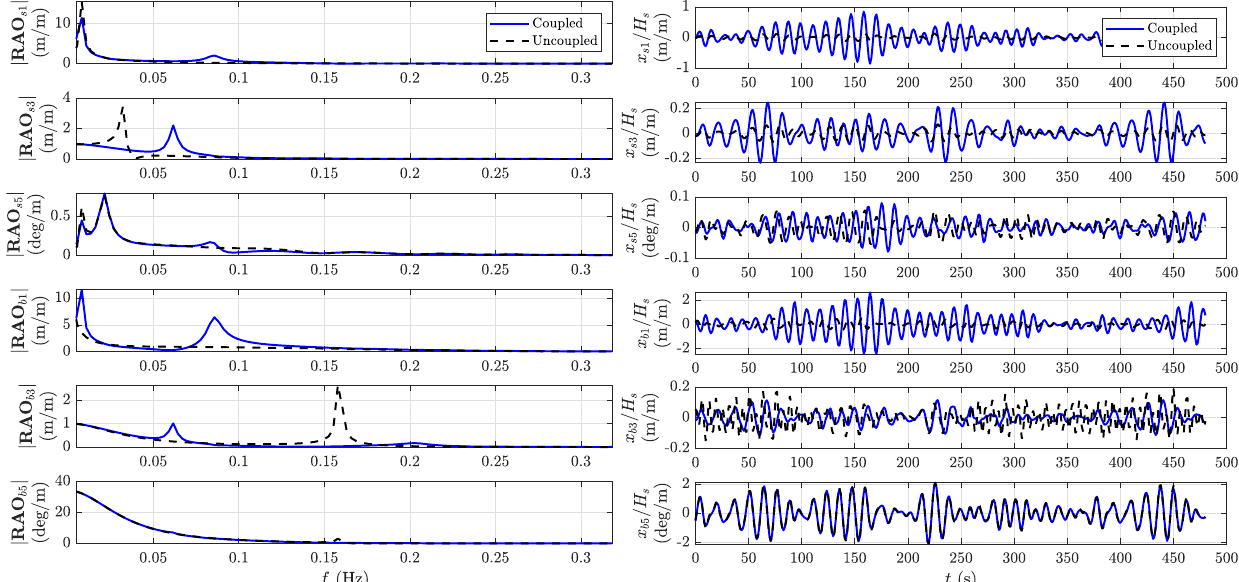
Figure 8. ( Left ): RAOs of spar and BA before and after coupling. ( Right ): Motion time series before and after coupling. Both plots are for R BA = 9.4m, D BA / R BA = 1.00, T p = 12 s , and ∆ x = 50m.